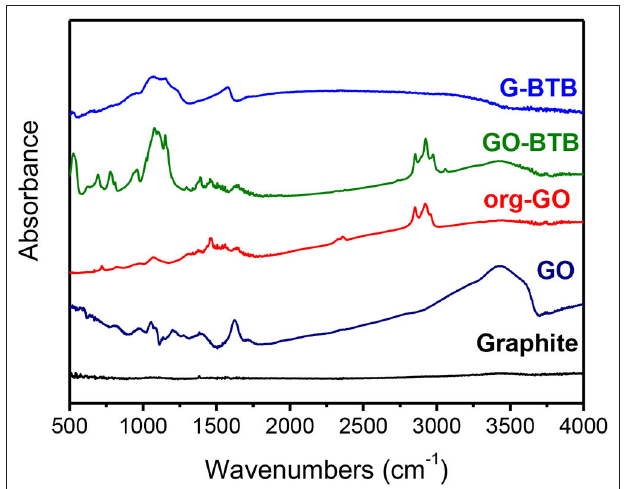
FIGURE 4 | FTIR spectra of the heterostructure prepared by silylation of organo-modified graphene oxide with 1,4-Bis(triethoxysilyl)-benzene before (GO-BTB) and after (G-BTB) calcination; the spectra of graphite, pristine graphene oxide (GO) and graphene oxide intercalated with dodecylamine (org-GO) are plotted for comparison.